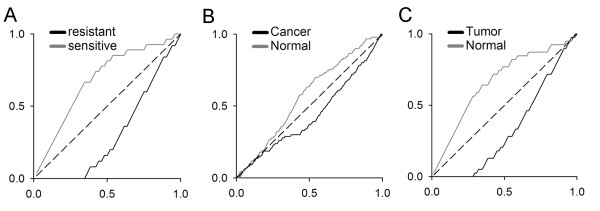
Enrichment plots for high scoring SPIED hits against the glucocorticoid (dexamethasone) resistant v sensitive profile query. The dexamethasone resistance query scores highly against a corticosteroid (prednisolone) resistance study. The enrichment plot is shown in A. Ordering the samples according to correlation score with the query profile the enrichment plot is the cumulative fraction of the given phenotype in the given sample fraction. Explicitly, if there are N correlation score ordered samples and two phenotypes defined by qi = ± 1 with i = 1,...,N, then the enrichment for the phenotypes is ek+-=±∑i=1kqi∑i=1Nqiand the enrichment plot is just ek+-against kN. The plot shows that sensitive samples are enriched for lower correlation scores and resistant samples are enriched for higher correlation scores. The enrichment plots for the lung cancer study is shown in B and for the pancreatic cancer study in C.